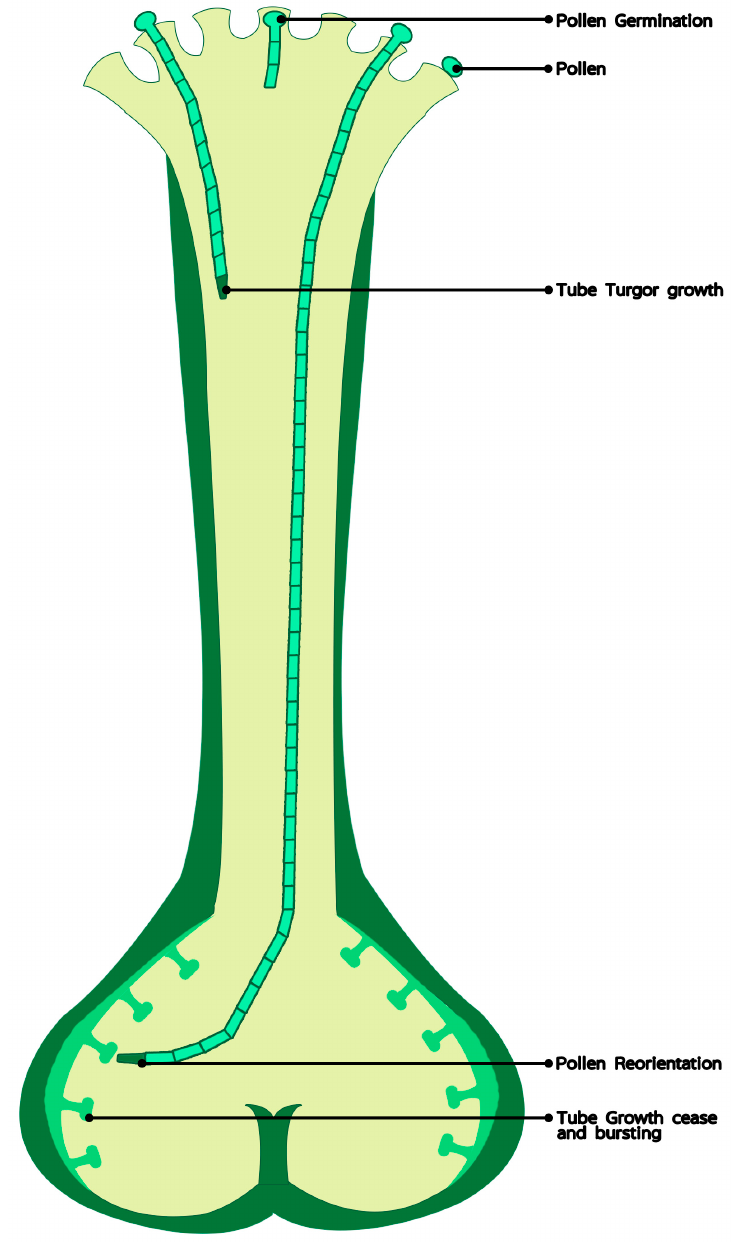
Figure 1. The role of calcium in pollen germination and tube elongation in vivo.